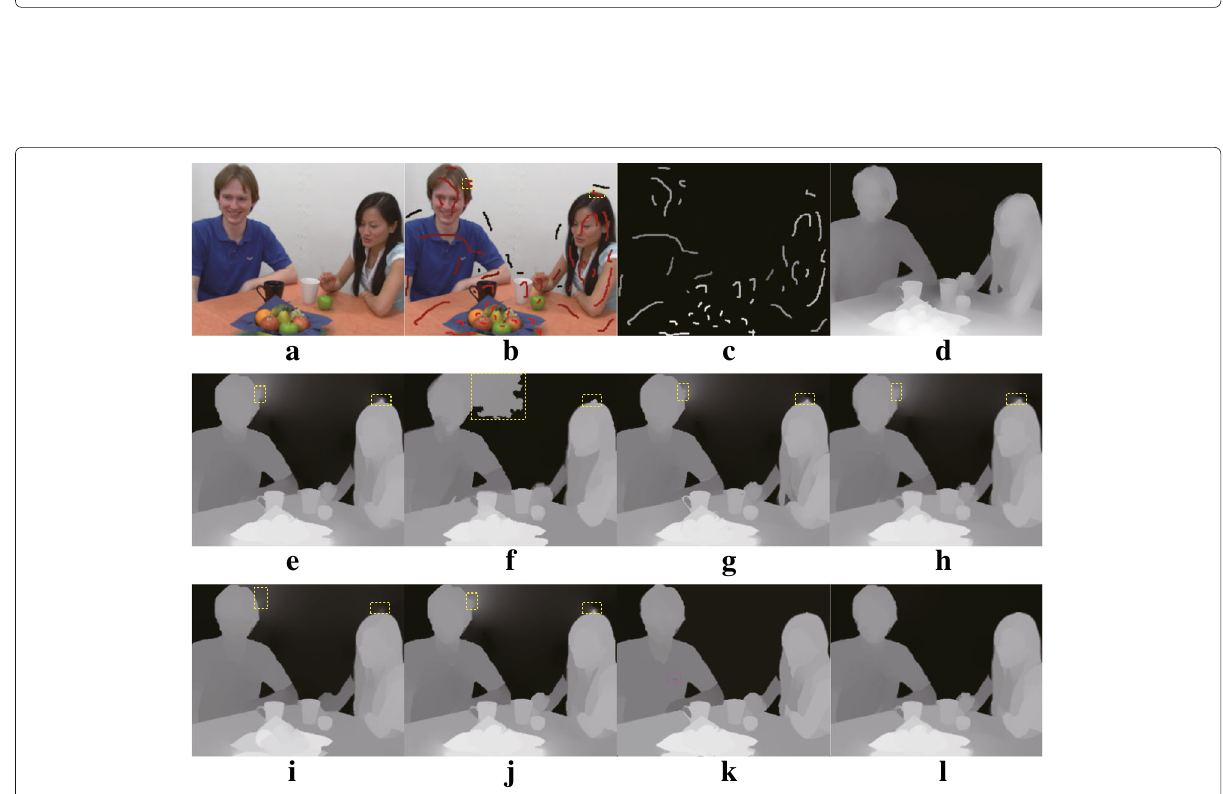
Fig. 5 Results of RGBZ_02 with cross-boundary input. a Input image. b User-labeled image. c Sparse depth. d Groundtruth depth. e Depth of RW. f Depth of HGR. g Depth of NRW. h Depth of OPT. i Depth of OCP. j Depth of SDF. k Depth of (cid:2) 1 . l Depth of the proposed method. Please zoom in to see